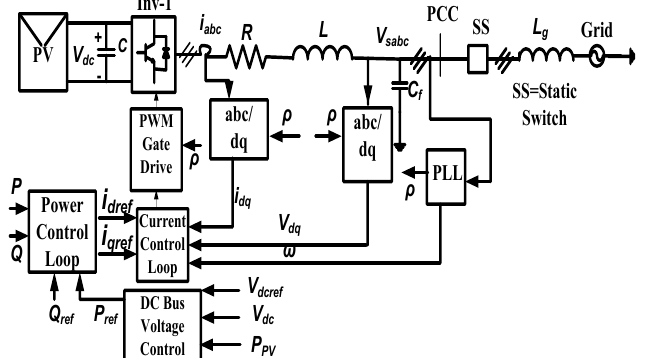
Fig. 2. Control scheme of PV